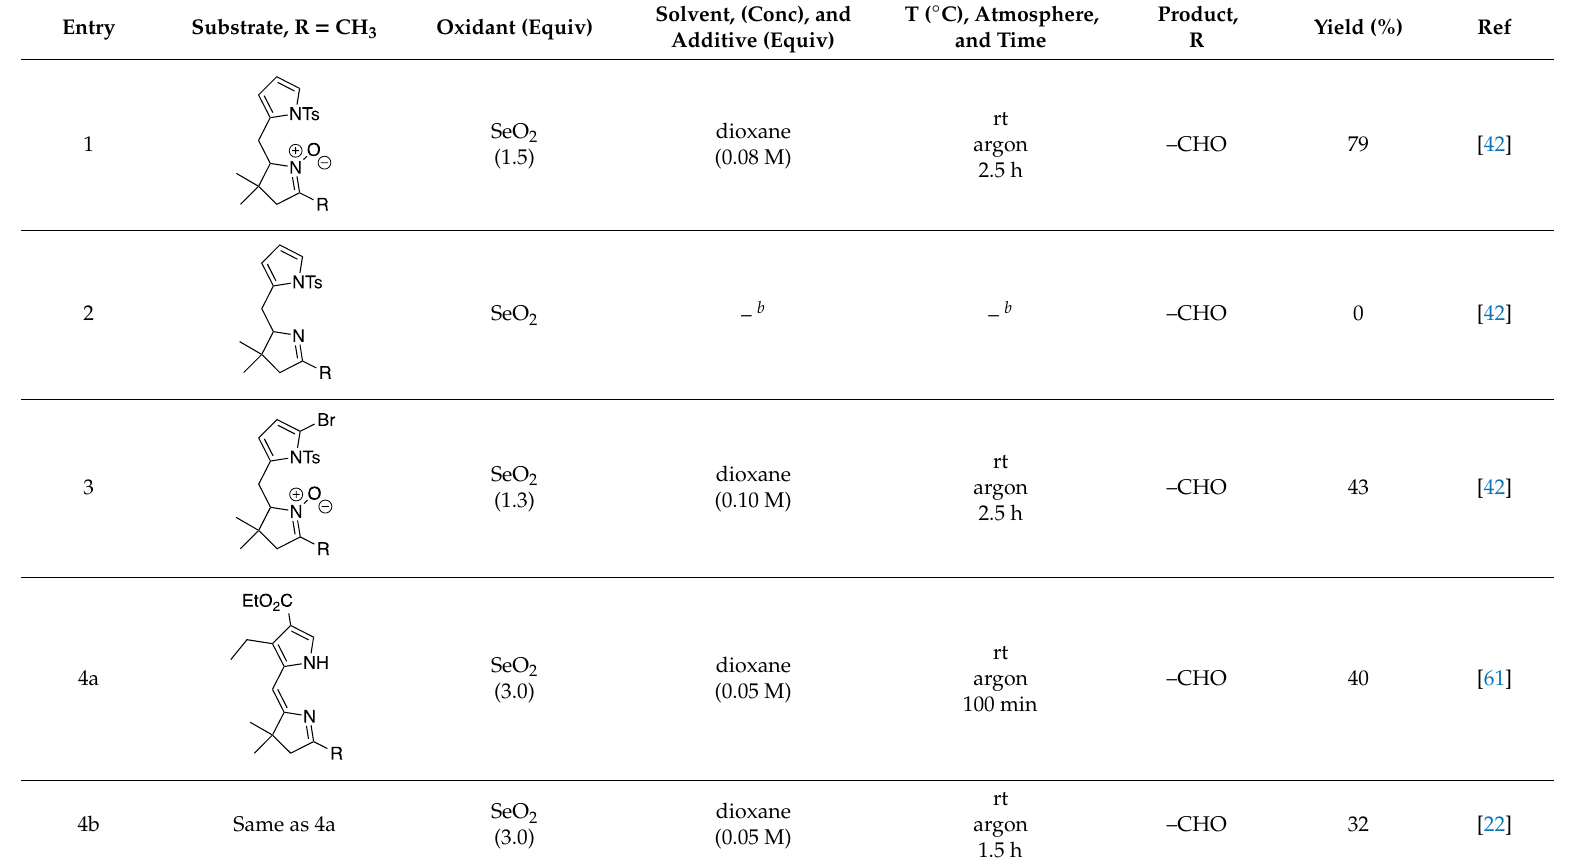
Table 1. Summary of Riley oxidation of hydrodipyrrins a.